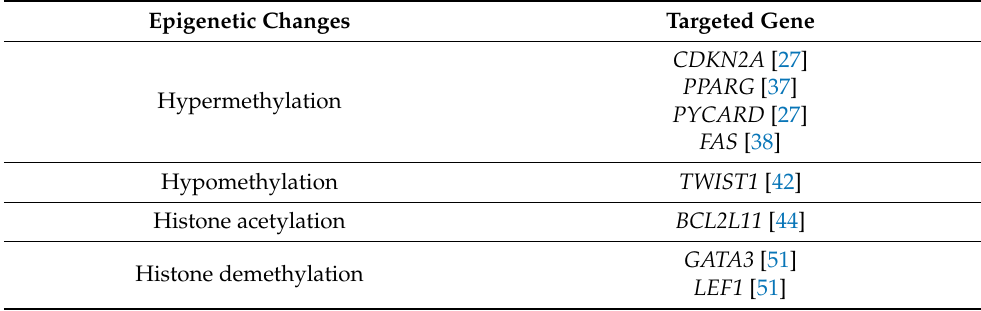
Table 1. Epigenetics targeted